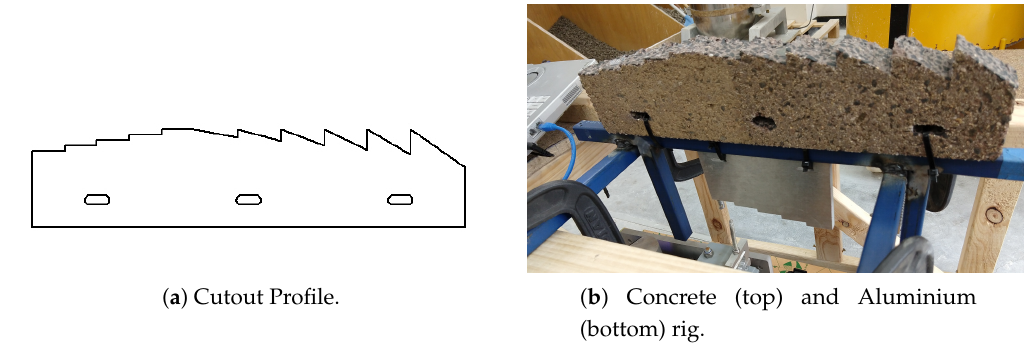
Figure 8. Cutouts for benchmarking the